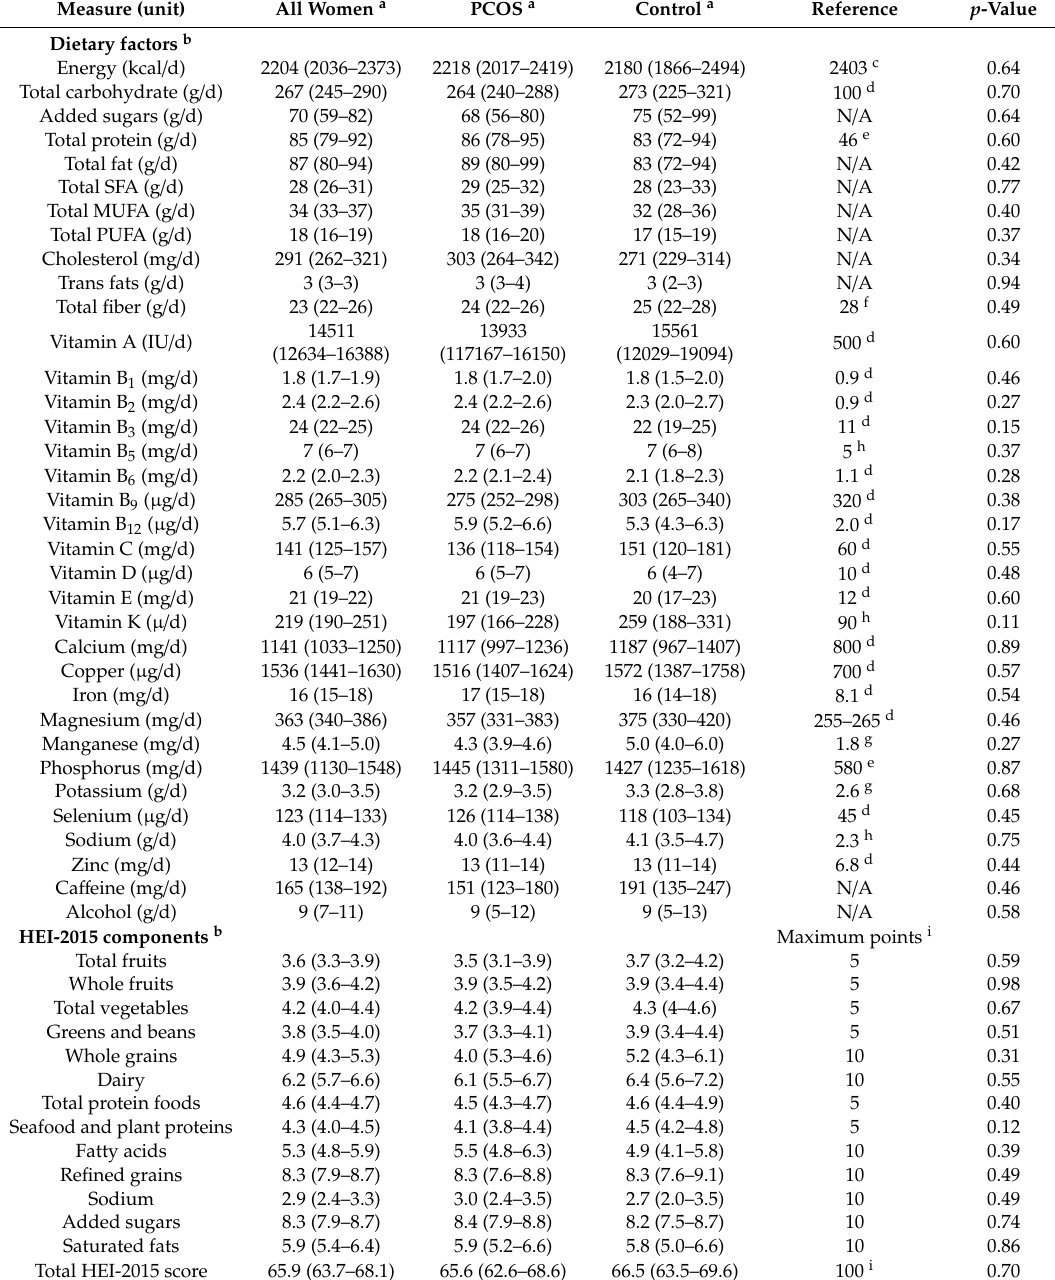
Table 2. Dietary intake and diet quality of women with polycystic ovary syndrome and